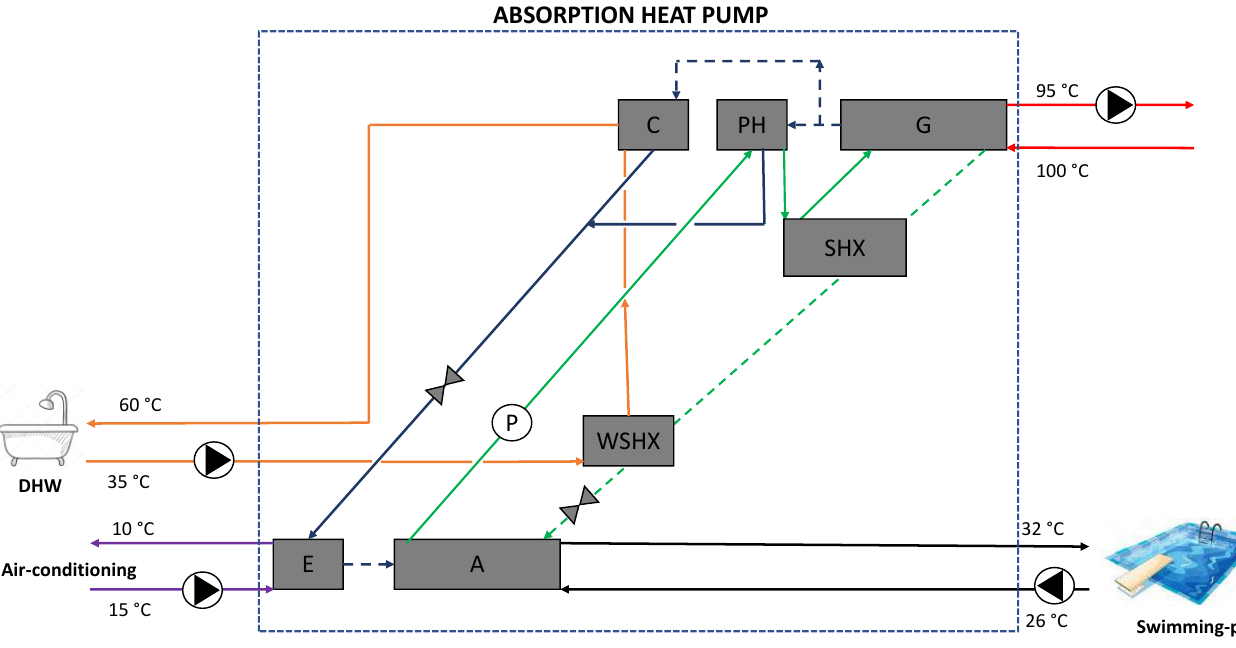
Figure 8. Layout for the simultaneous heating and cooling for a sports center with an indoor swimming pool application.